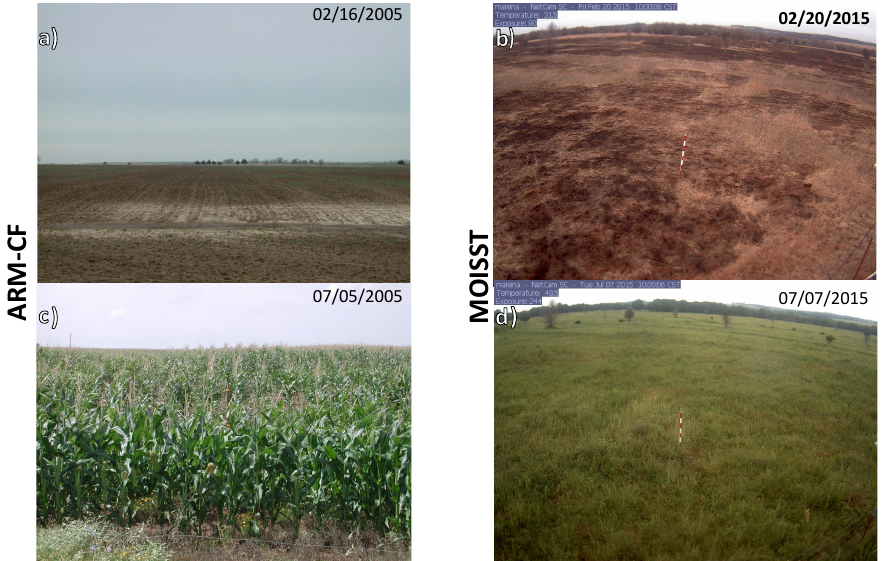
Figure 2. Phenocam images of the ARM-CF site (left column) and MOISST site (right column) during typical days of the cool (February) and warm (July) seasons. Note the changes in vegetation cover and activity. Table 1. Geographic coordinates, soil and vegetation type, and purpose of the four selected EC sites. ID Lat,